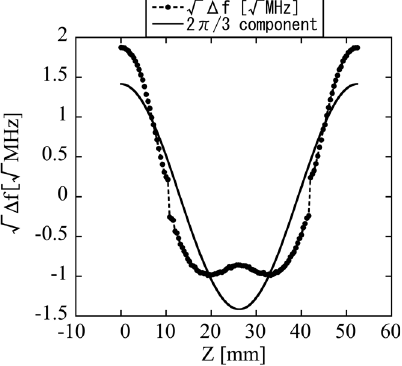
FIG. 6. Change in frequency, i.e., Δ f (acceleration-field pattern) as a function of the position of the bead and the TM 01 − 2 π = 3 -mode acceleration-field pattern reconstructed from the Δ f data. The dashed line with the solid circles represents the on-axis acceleration electric-field pattern measured by the bead-pull perturbation method; the solid black curve is the reconstructed TM 01 − 2 π = 3 accelerating mode.